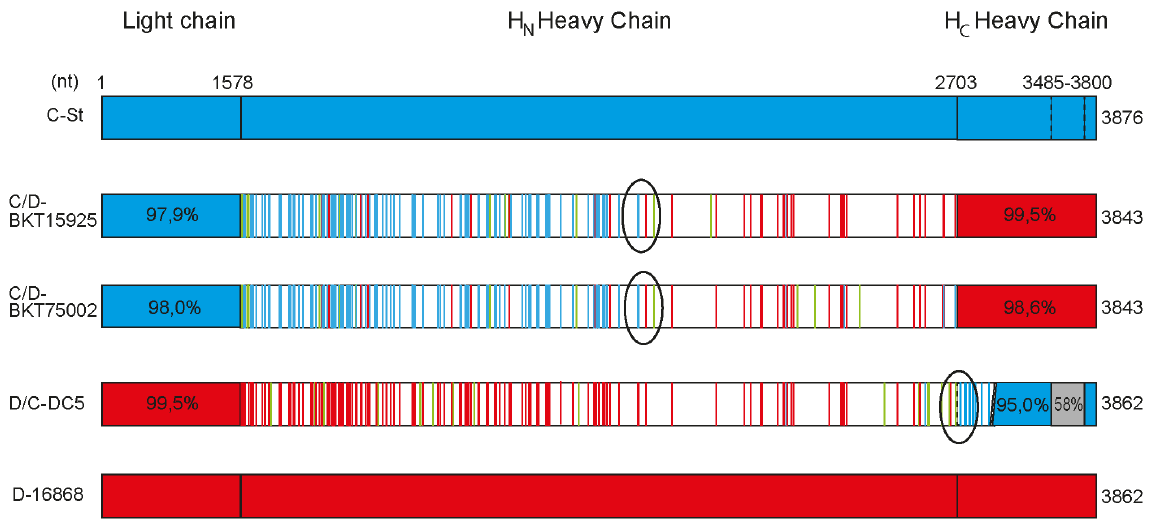
Figure 4. Alignment of chimeric bont sequences in comparison with non-chimeric sequences. Chimeric sequences are aligned against non-chimeric sequences from type C strain C-Stockholm (lineage II) and type D strain 16868 (lineage I). The chimeric sequences are from type C/D strains BKT015925 and BKT75002, and type D/C strain DC5 (all from lineage I). In the H N domain, nucleotides that are conserved are not colored, whereas unique nucleotides are marked in green, nucleotides corresponding to the C-sequence are marked in blue, and nucleotides corresponding to the D-sequence are in red. The light chain and the H C domain are not represented according to scale and they are colored as the closest related sequence. Estimated recombination sites are indicated.